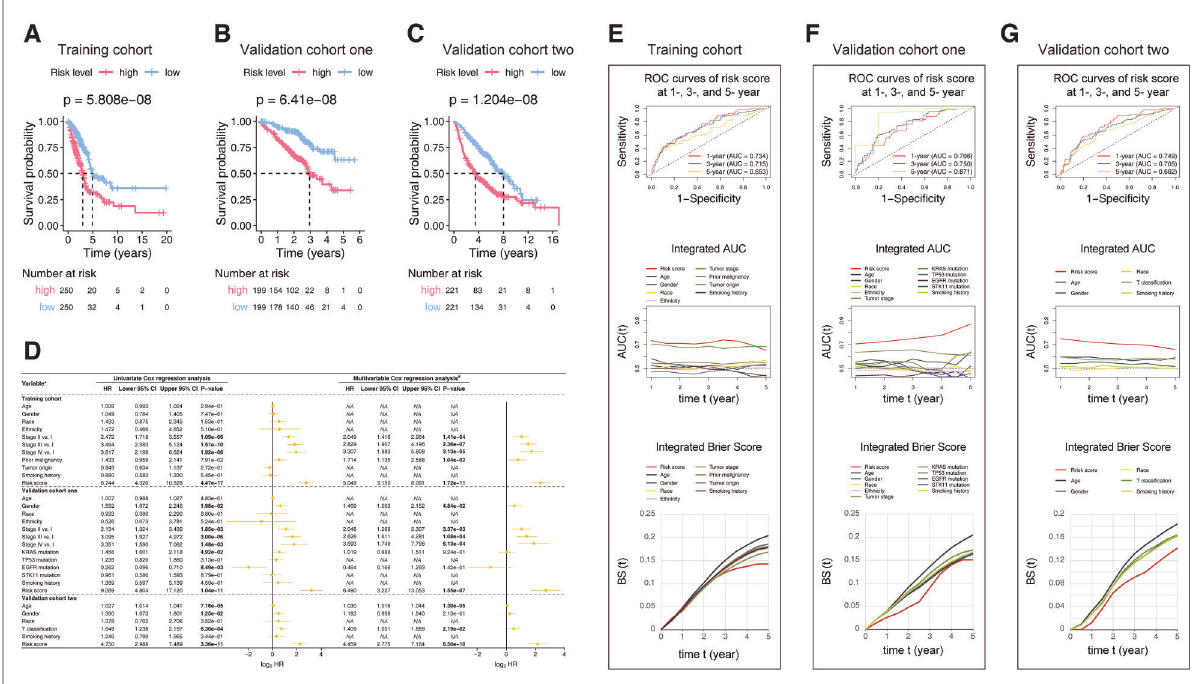
FIGURE 3 Kaplan-Meier analysis ( A – C ), Cox models ( D ), ROC, iAUC, and IBS ( E – G ) constructed in the studied cohorts. ( A – C ) Patients in each cohort were divided into low-risk groups and high-risk groups based on their median risk score. The log-rank test with a p -value<0.05 suggests the survival difference is signi fi cant. The lower part displays the number of patients at risk. ( D ) The comparison methods involved in the studied cohorts, explains as follows: Gender: male vs. female; Race: white vs. non-white; Ethnicity: Hispanic or Latino vs. non-Hispanic or Latino; Prior malignancy: yes vs. no; Tumor origin: upper lobe lung vs. non-upper lobe lung; Smoking history: ever vs. never; KRAS mutation: yes vs. no; TP53 mutation: yes vs. no; EGFR mutation: yes vs. no; STK11 mutation: yes vs. no; T classi fi cation: T2-T4 vs. T1; Only univariate variables with p -values less than 0.1 were included in the multivariable analysis; The bold p -value indicates that <0.05, which considers signi fi cant. ( E – G ) The ROC curves valued the accuracy for LUAD outcome prediction of our signature at 1-, 3-, and 5-year, respectively. The IAUC and IBS analyses compared our signature ’ s prognostic ability with other available clinical characteristics. The larger the AUC, or the smaller the BS, the stronger the model ’ s predictive ability. HR, hazard ratio; CI, con fi dence interval; ROC, receiver operating characteristic; AUC, area under the ROC curve; IAUC, integrated AUC; BS, Brier score; IBS, integrated Brier score; LUAD, lung